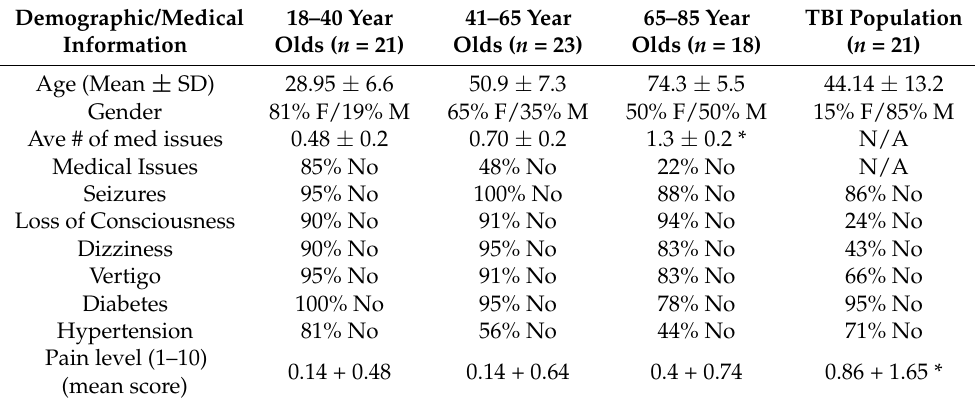
Table 1. Demographic/Medical Intake information